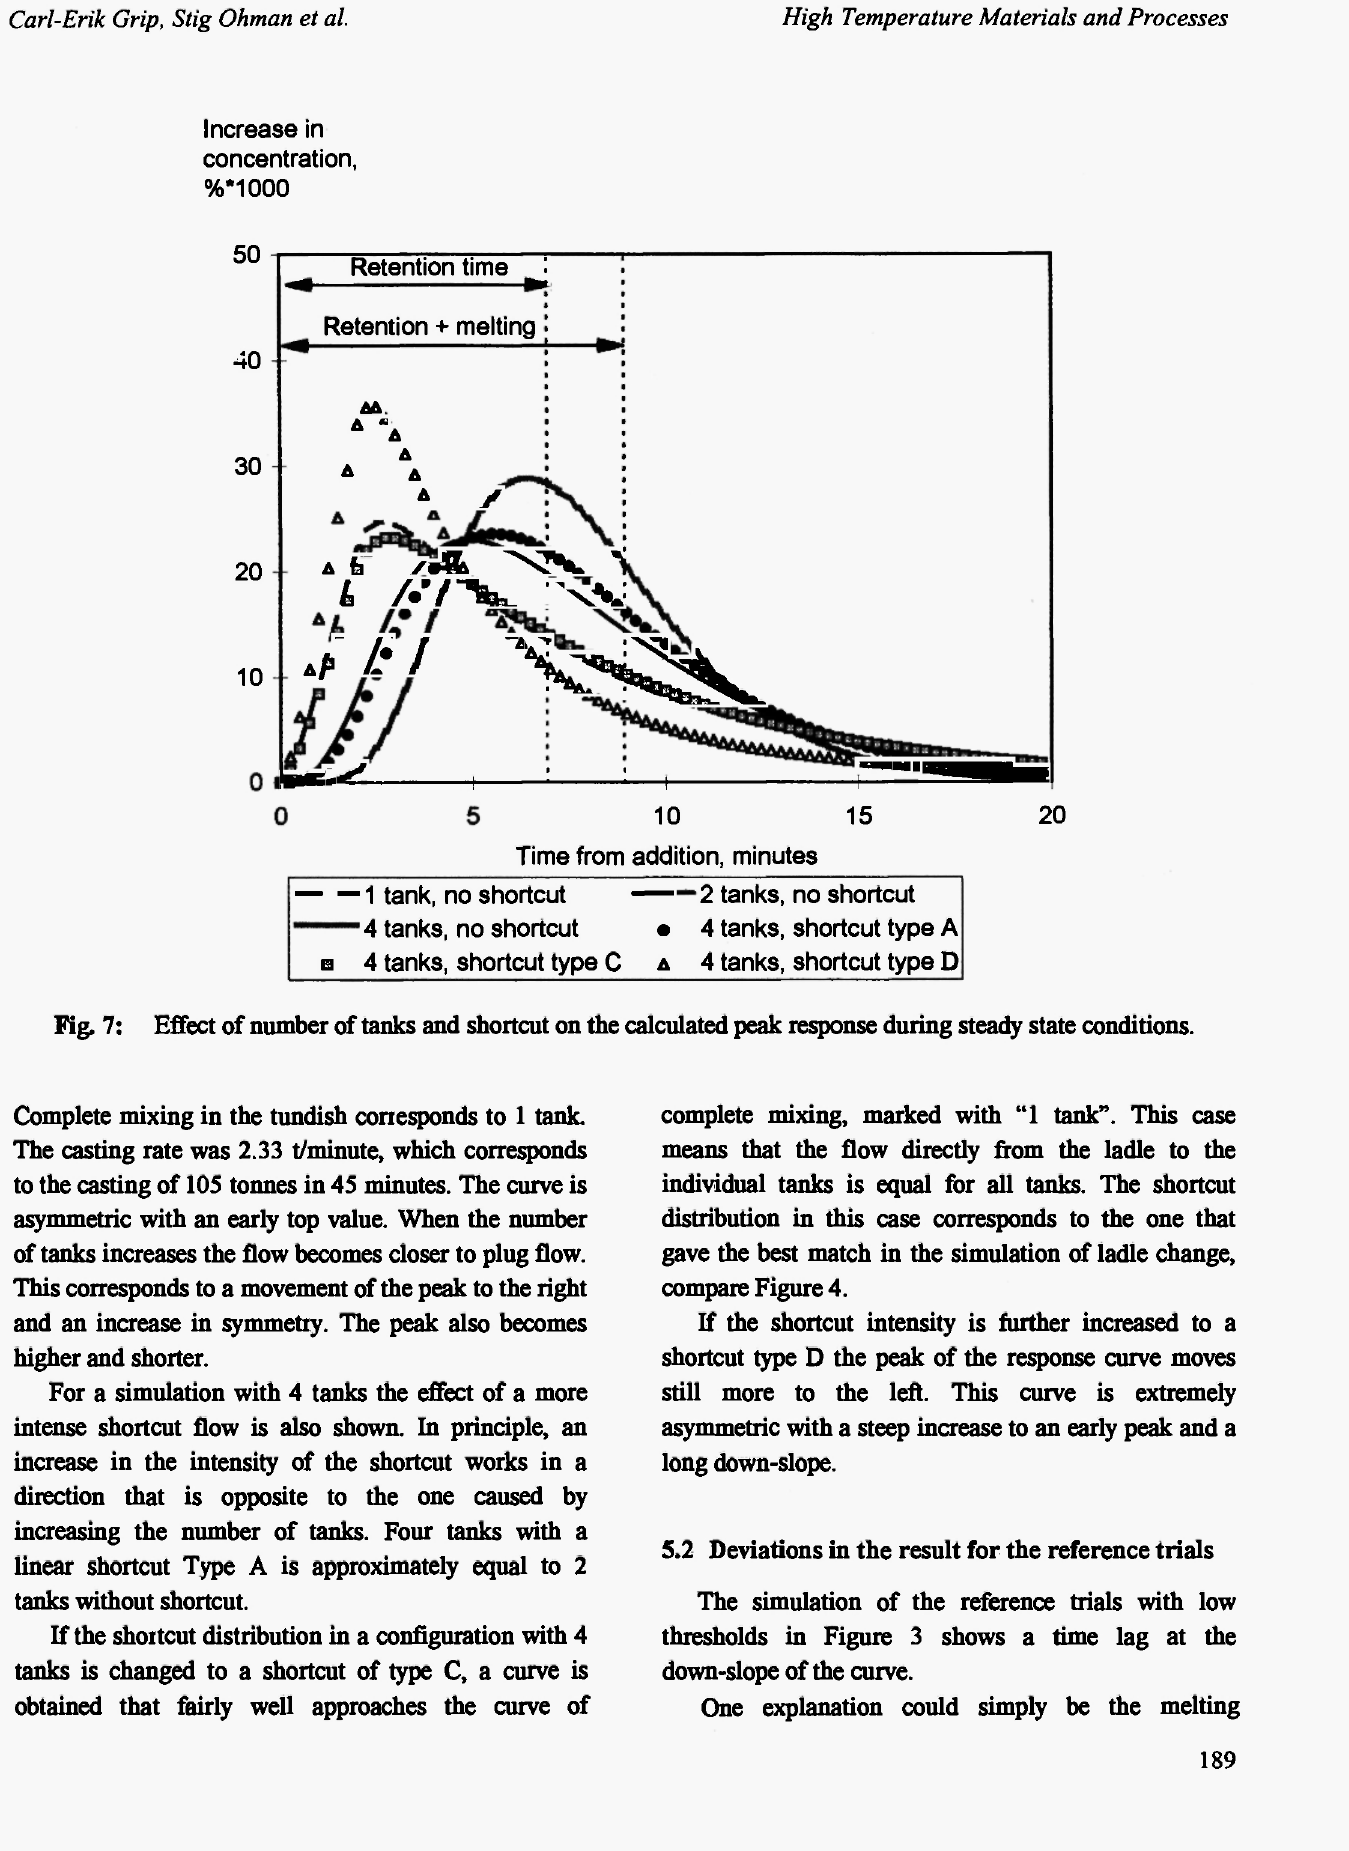
Effect of number of tanks and shortcut on the calculated peak response during steady state conditions. Complete mixing in the tundish corresponds to 1 tank. The casting rate was 2.33 t/minute, which corresponds to the casting of 105 tonnes in 45 minutes. The curve is asymmetric with an early top value. When the number of tanks increases the flow becomes closer to plug flow. This corresponds to a movement of the peak to the right and an increase in symmetry. The peak also becomes higher and